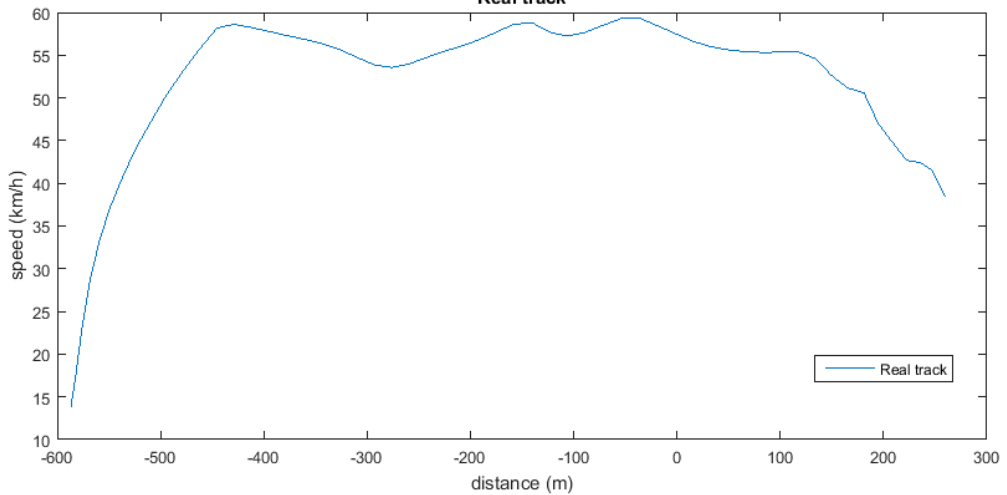
Figure 10. Real track curve of speed versus distance.